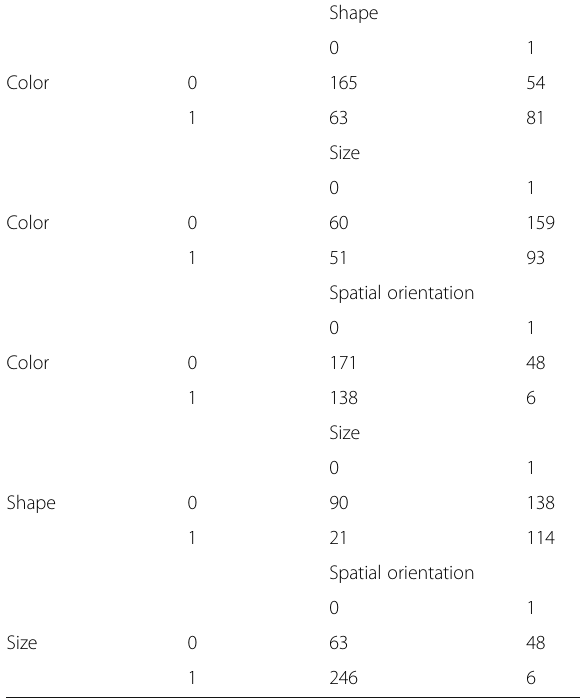
Table 5 2 × 2 classification tables for McNemar